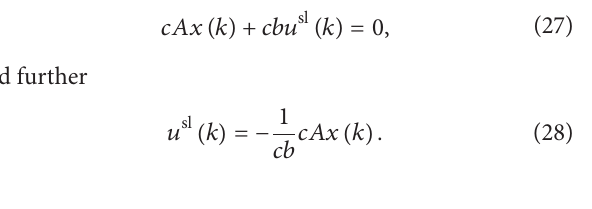
Figure 5: Example of function 𝑔(𝑥 1 ,𝑥 2 ) for 𝐿 = 𝐻 = 1 , 𝐺 = 𝐺𝑢 = 1 , and 𝑐1 = 𝑐2 = 1